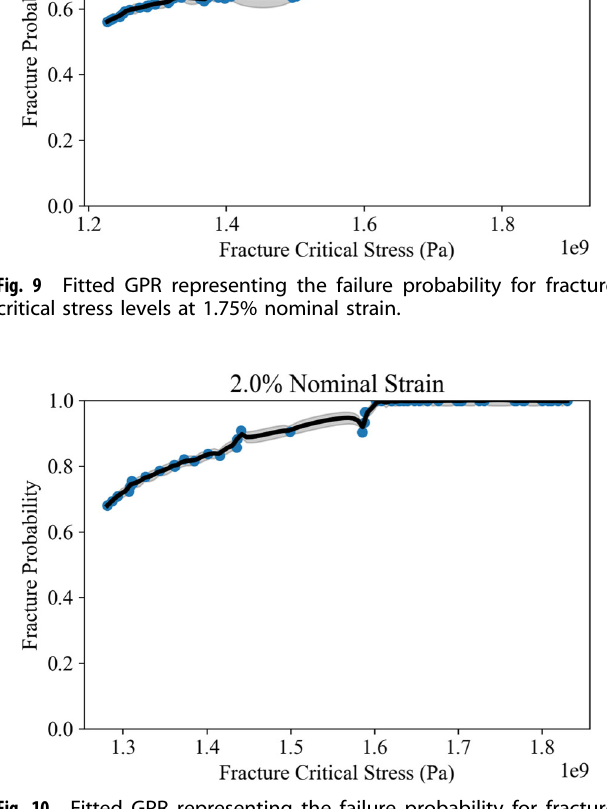
Fig. 10 Fitted GPR representing the failure probability for fracture critical stress levels at 2.0% nominal